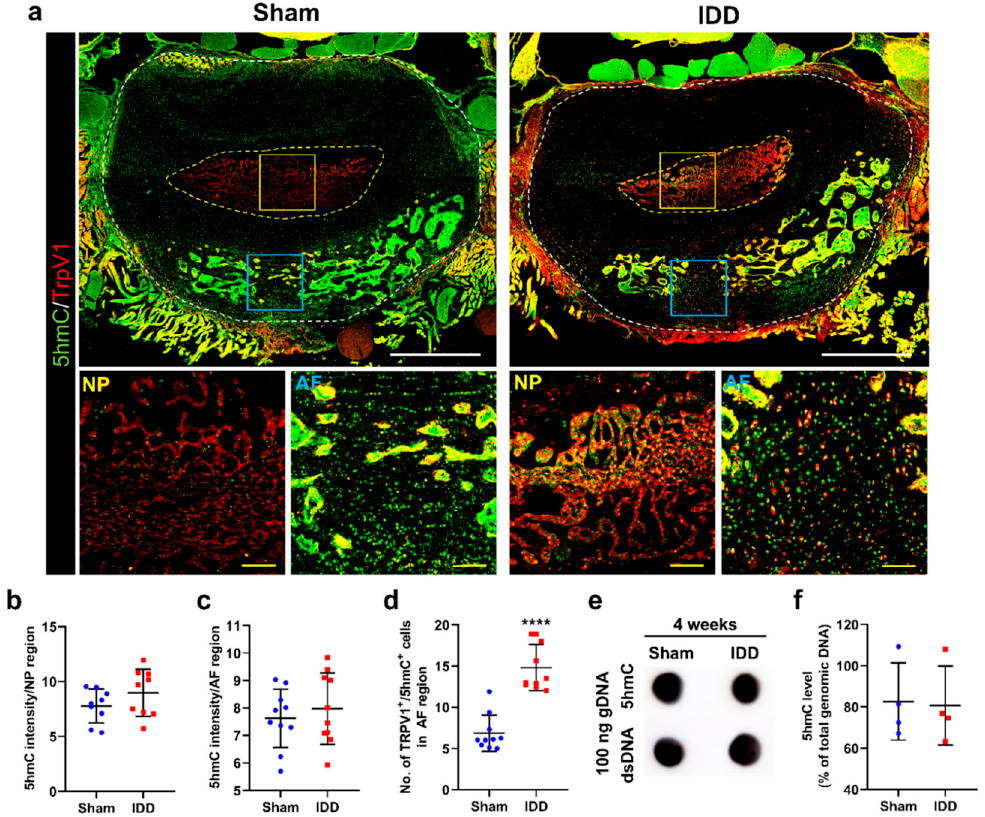
Figure 6. ( a ) Representative immunohistochemical low and high images for 5hmC (green) and TrpV1 (red) in the NP and AF regions of the sham and IDD groups White scale bar = 1000 µ m, Yellow scale bar = 100 µ m; ( b , c ) Relative intensity of 5hmC expression in the NP and AF regions of the sham and IDD groups ( n = 10/group); ( d ) Percentage of cells double-stained with TrpV1 (red) and 5hmC (green) in the AF regions of the sham and IDD groups ( n = 10/group); ( e ) DNA dot blot results for 5hmC levels in L4/5 and L5/6 discs of the sham and IDD groups at 4 weeks; ( f ) Quantitative results from dot blot assay of 100 ng of DNA for 5hmC normalized with the total amount of genomic DNA in the sham and IDD groups ( n = 4/group). Data are expressed as the mean ± SEM. Significant differences indicated as **** p < 0.0001 vs. sham group were analyzed via unpaired t -tests with Welch’s correction. 5hmC, 5-hydroxymethylcytosine; AF, annulus fibrosus; IDD, intervertebral disc degeneration; NP, nucleus pulposus; SEM, standard error of the mean; TrpV1, transient receptor potential vanilloid subtype 1.